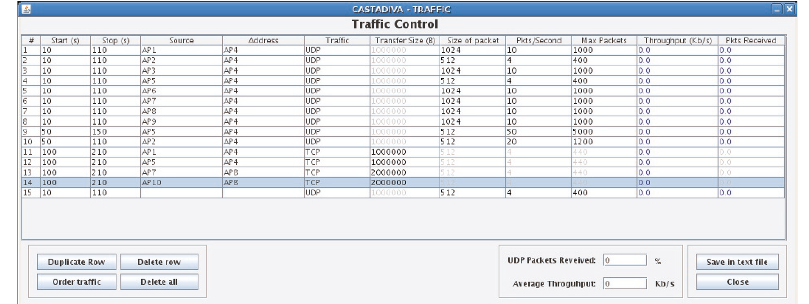
Figure 8: Tra ffi c declaration